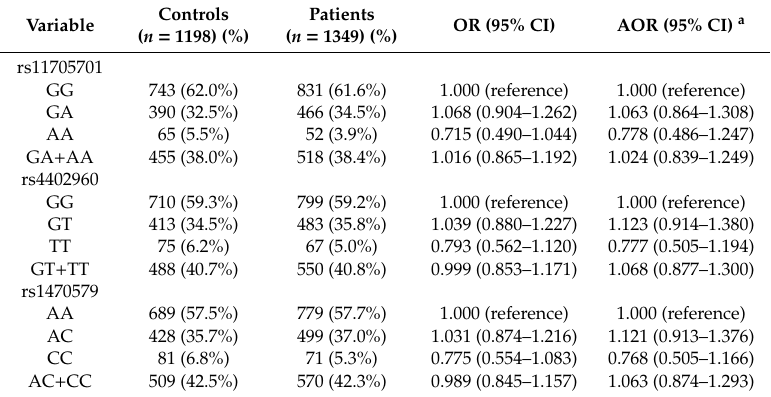
Table 2. Odds ratios and 95% CIs of oral cancer associated with IGF2BP2 genotypic frequencies.